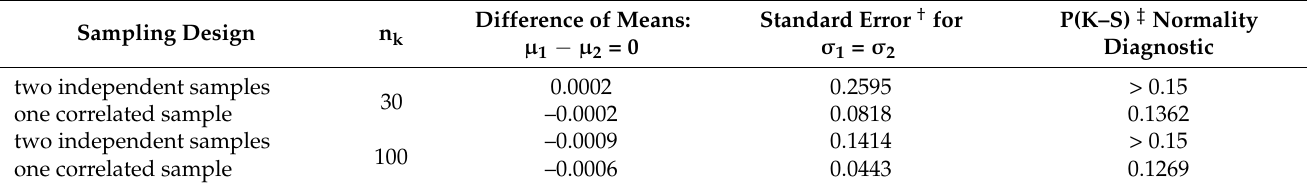
Table 2. Simulated CLT results for the difference of two means sampling distributions, with ρ = 0.9 for the correlated samples; 10,000